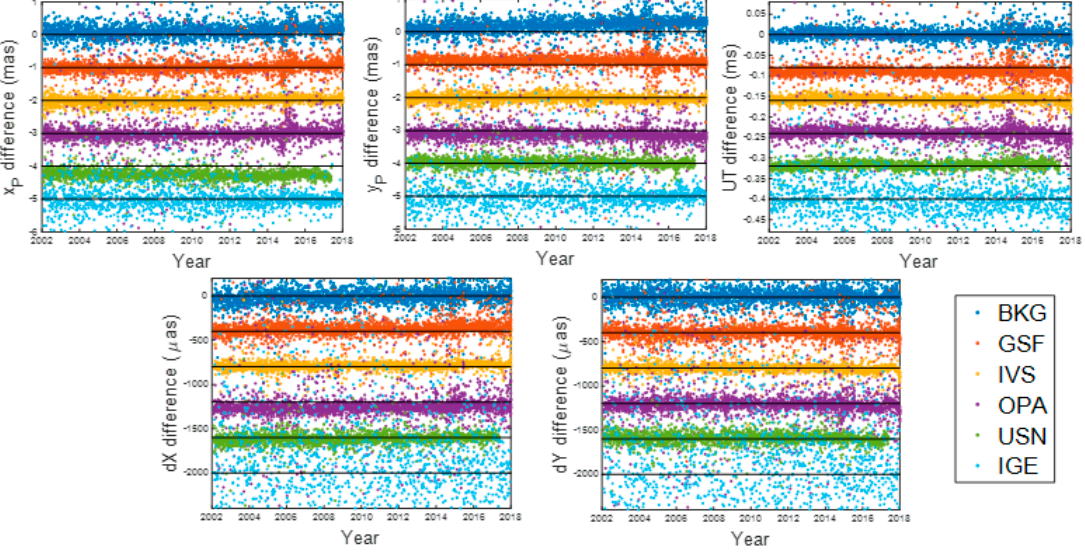
Figure 1. EOP differences with respect to EOP 14 C04 series